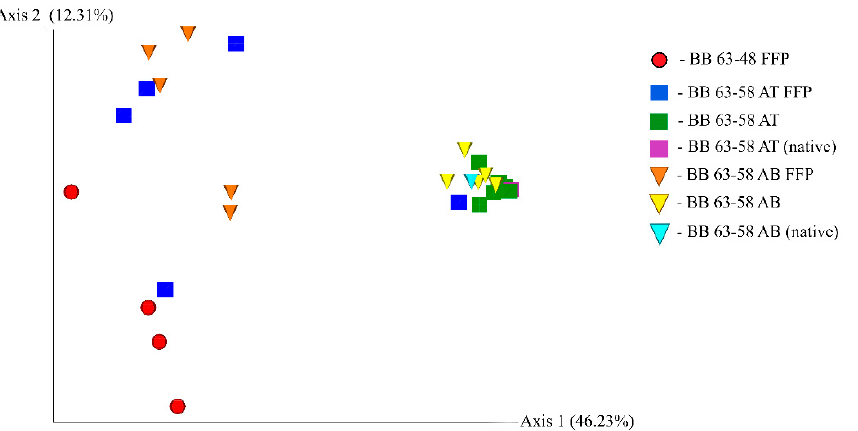
Figure 8. Two-dimensional diagram of the phylogenetic similarity of bacterial communities of the horizons of the studied Antarctic soils according to the results of unweighted UniFrac.